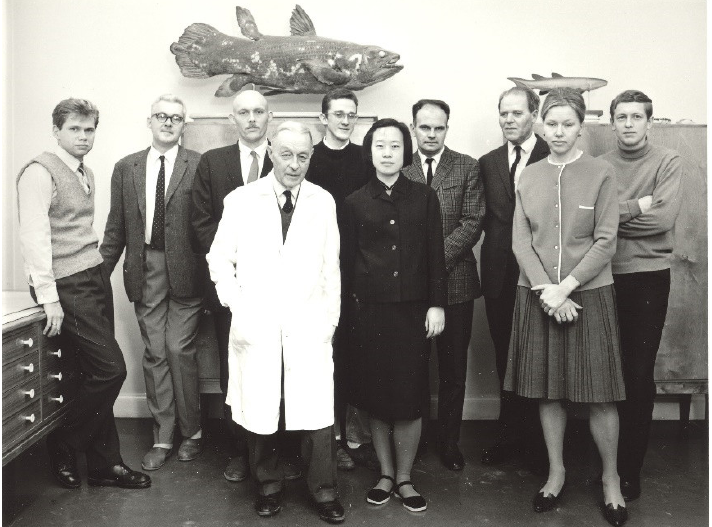
Figure 3. Miman Zhang and her colleagues in Stockholm, Sweden in 1966. Front row, front the left: Erik Stensiö, Miman Zhang, E. Mark-Kurik. Back row, from the left: Hans-Peter Schultze, Tor Örvig, Hans Bjerring, Gareth Nelson, Ray Thorsteinsson, Erik Jarvik, and Hans Jessen (credit to IVPP).